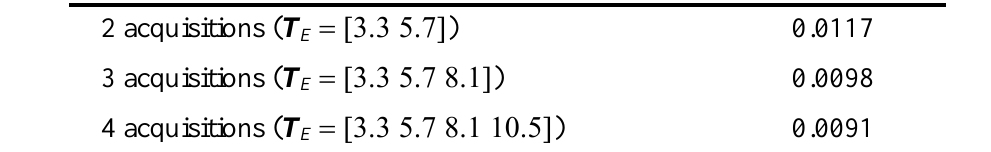
Table 1. Normalized mean square error for different number of available acquisitions— discontinuities free field map